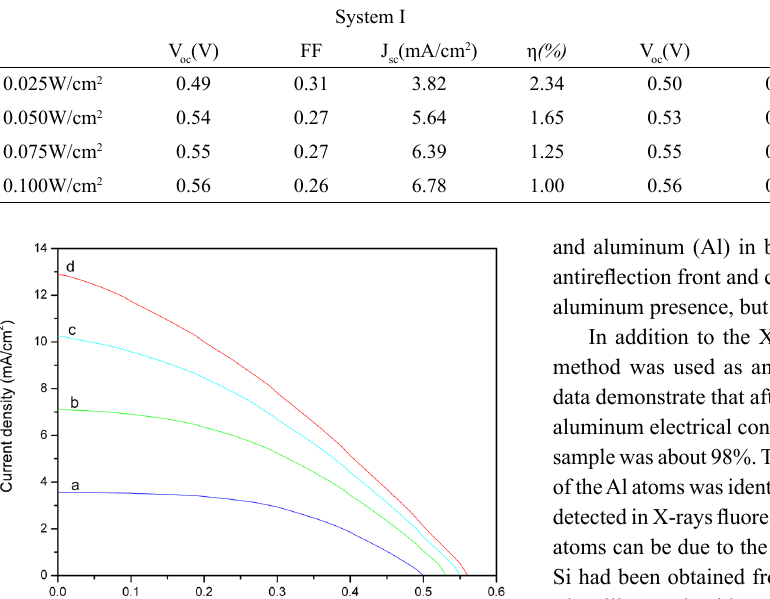
Table 1. Photovoltaic parameters for both systems.